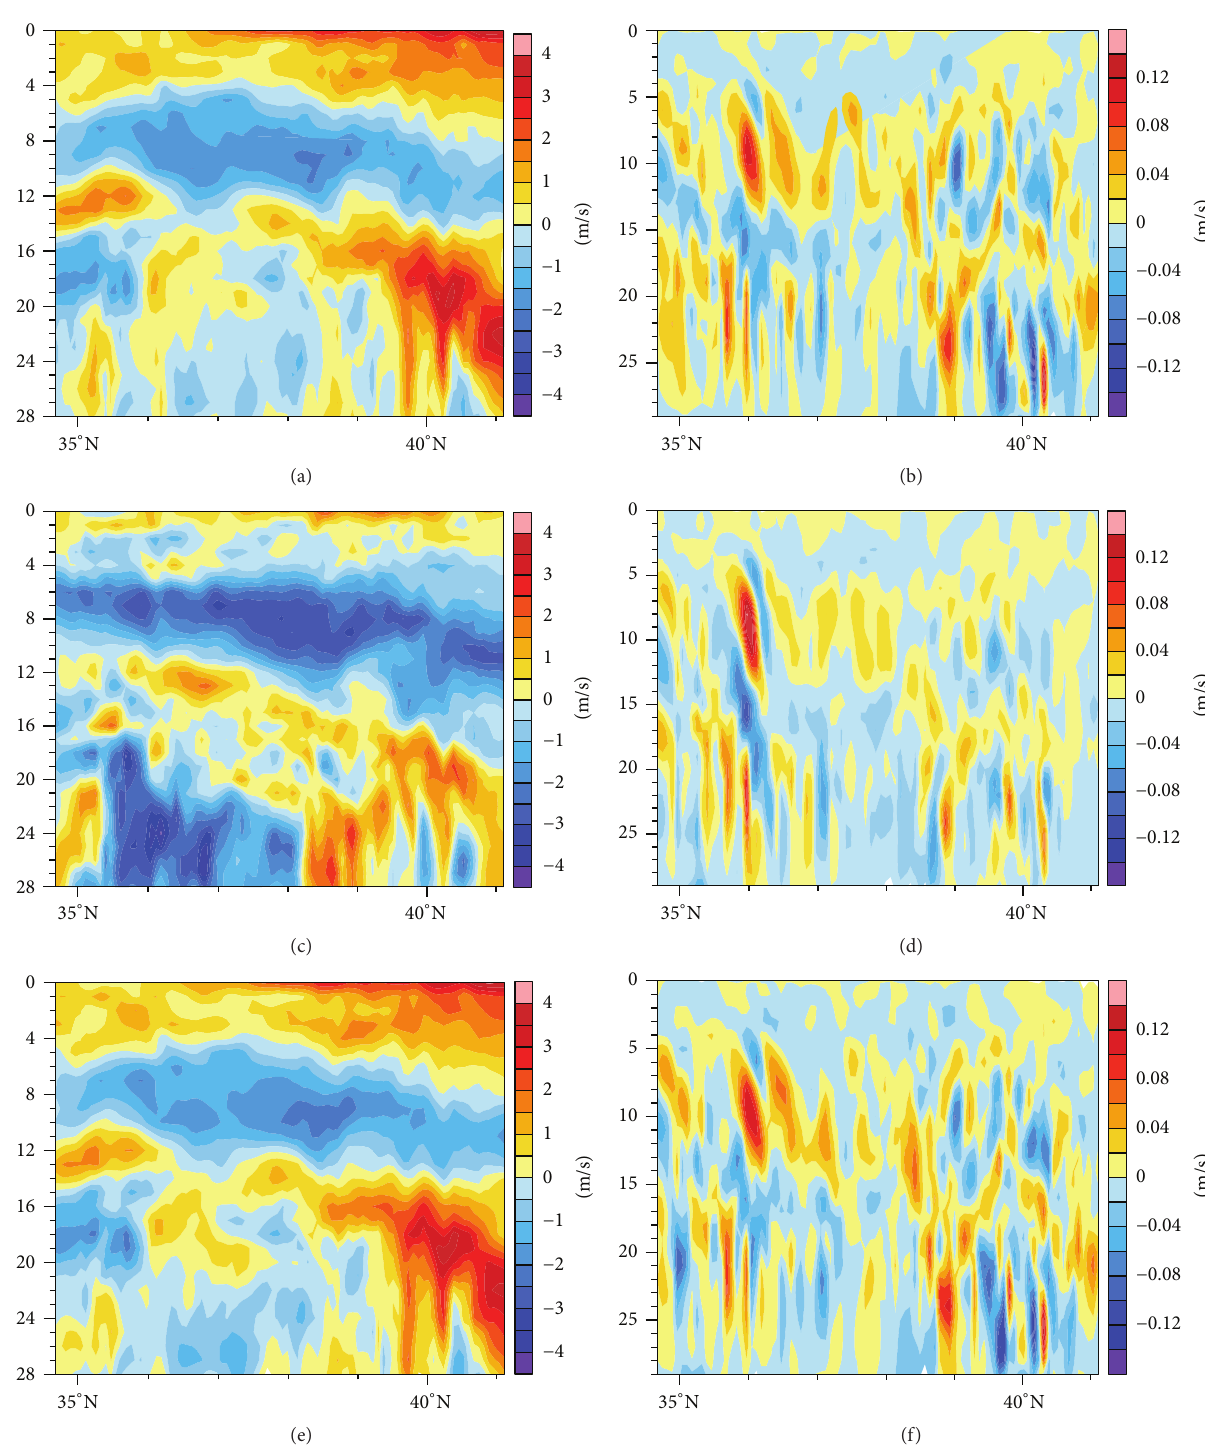
Figure 11: Vertical profile difference for average U and W wind speed along 100.46 ∘ E in June: (a) INTL-CTRL for U wind speed, (b) INTL- CTRL for W wind speed, (c) MODS-CTRL for U wind speed, (d) MODS-CTRL for W wind speed, (e) INMO-CTRL for U wind speed, and (f) INMO-CTRL for W wind